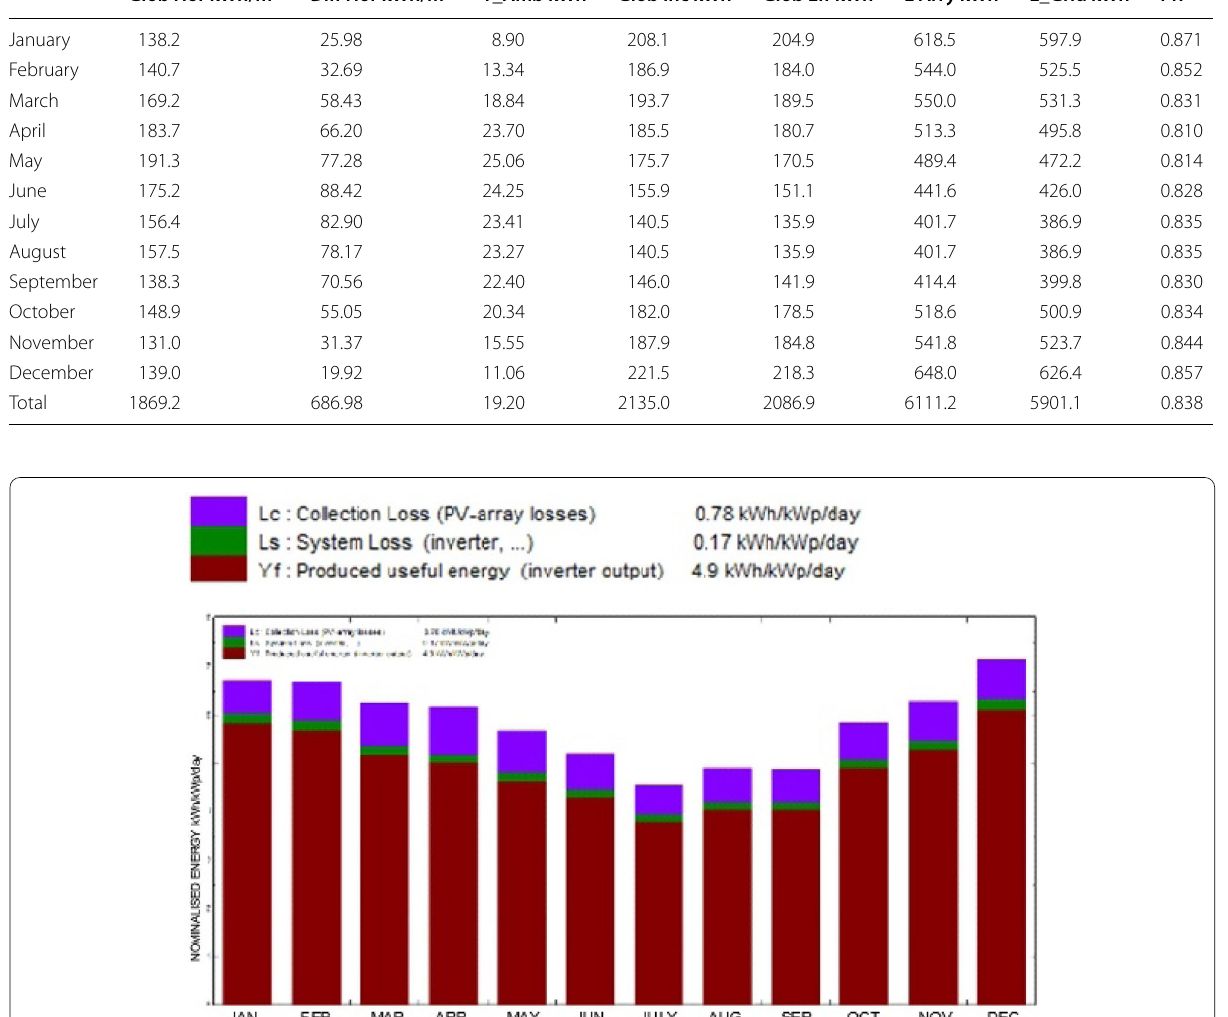
Table 8 Balances and performances of the proposed grid-connected PV system in Kathmandu Glob Hor kWh/m 2